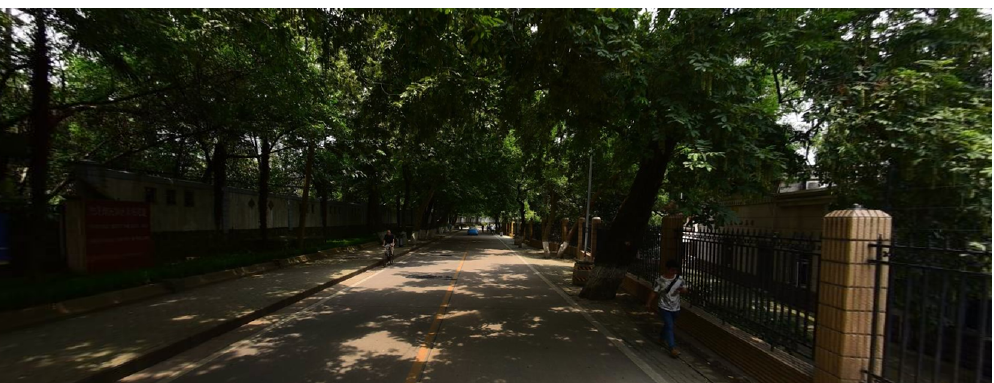
Figure 11. Test trajectory in urban area.